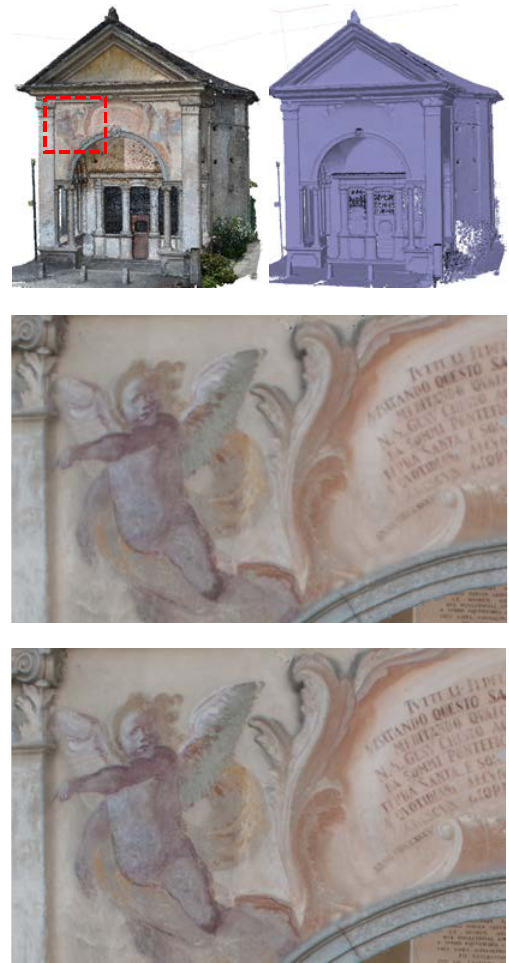
Figure 5: 3D model of Chapel 2 (Sacro Monte del Calvario di Domodossola – Italy) on the top. The details show the difference between a model with 1 texture (center) and 8 textures of 4096x4096 pixels